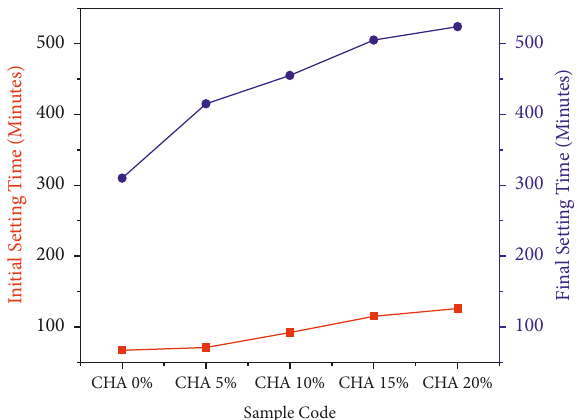
Figure 5: Initial and final setting time of pastes containing CHA.